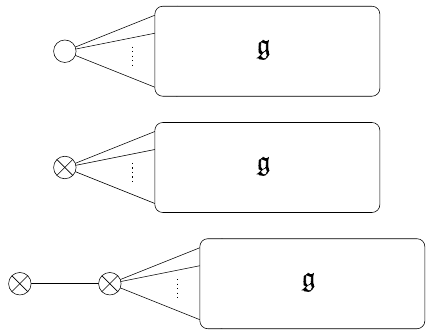
Figure 1 . Dynkin diagrams for the extended (super)algebras A , B and C . The box represents the Dynkin diagram of g